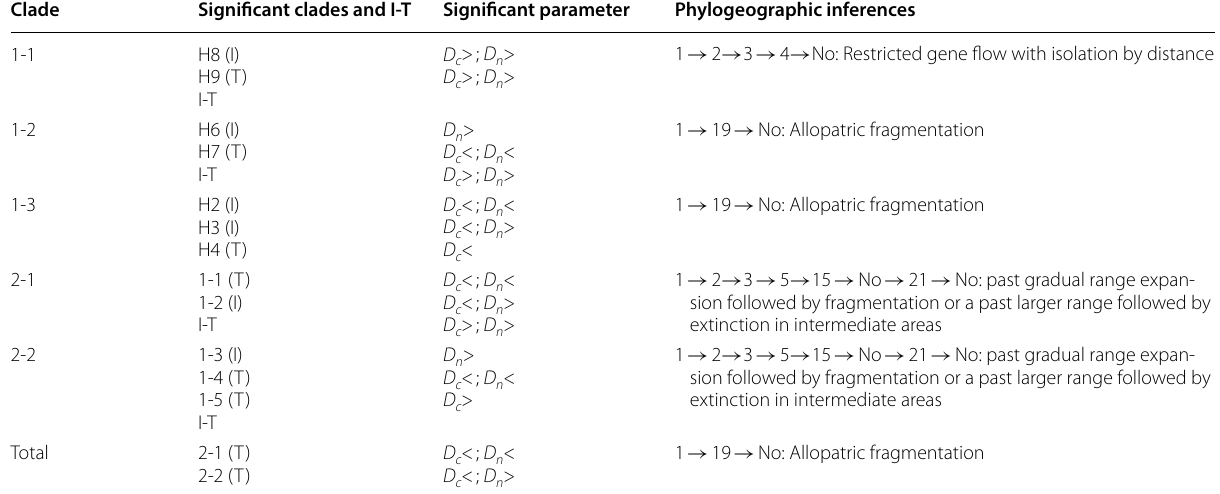
Phylogeographic inferences are inferred by applying the inference key of Posada et al. (2000) (http://darwi n.uvigo .es/softw are/geodi s.html) (T): tip; (I): interior; D c : clade distance; D n : nested clade distance; I-T: interior vs. tip